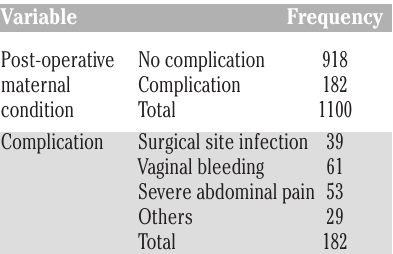
Table 5. The distribution complication after cesarean section delivery at DBRH